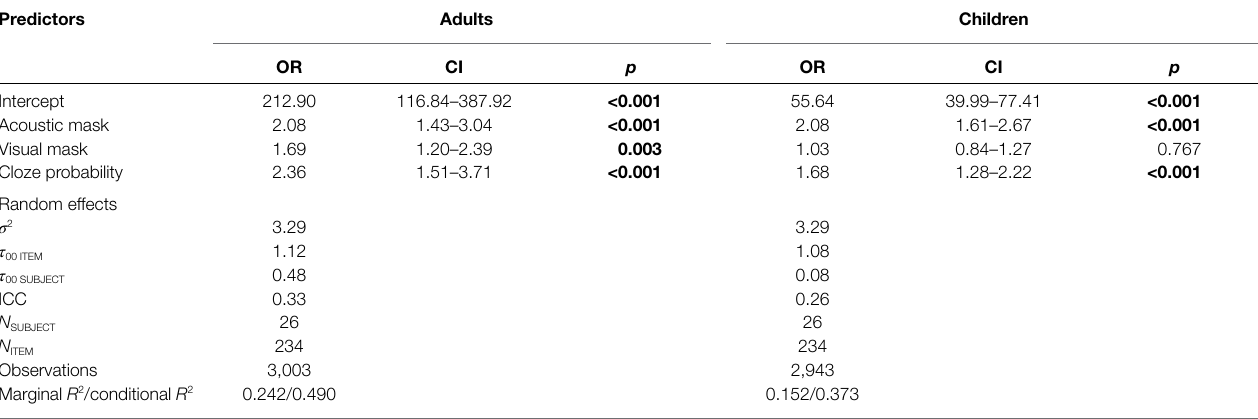
TABLE 2 | Optimized generalized mixed-effects regression models for adults and children, respectively, with accuracy as response variable. Predictors Adults